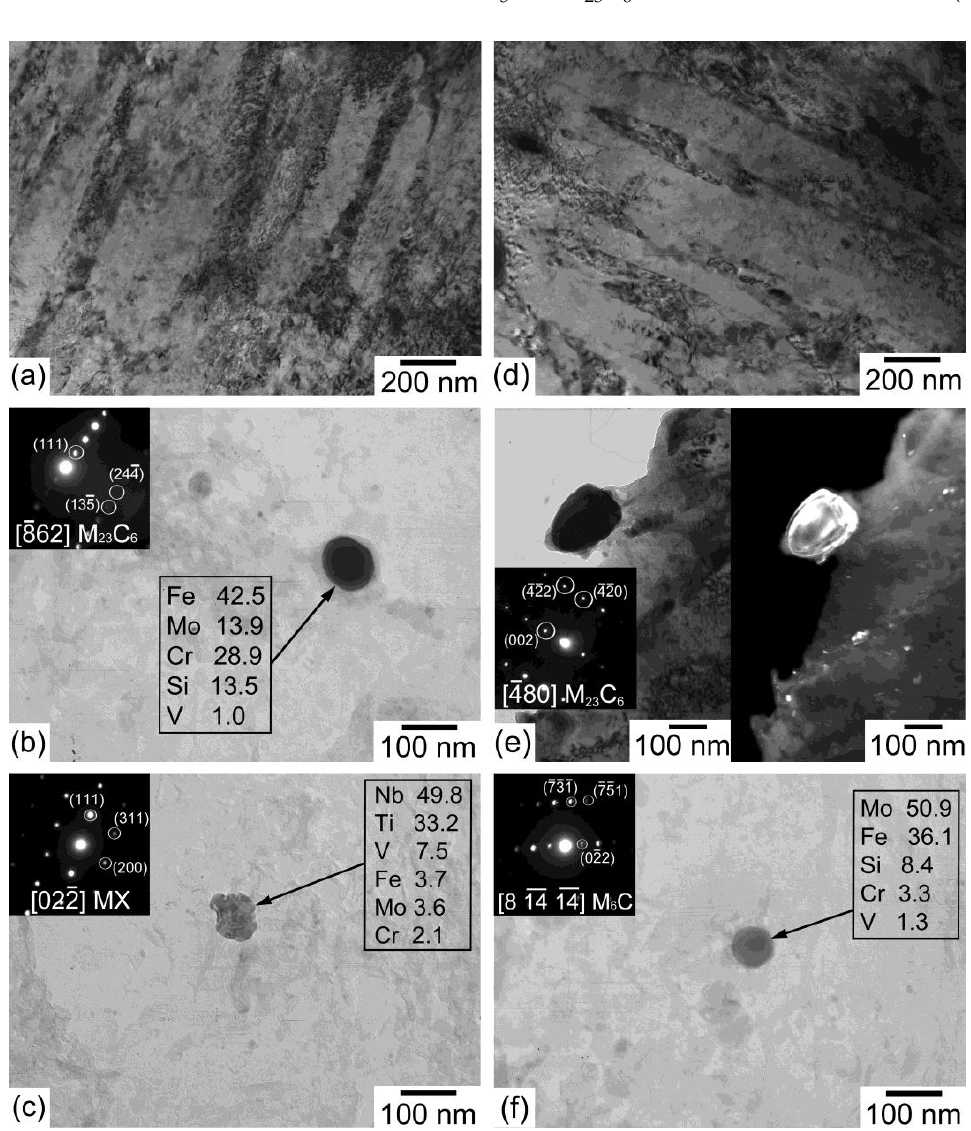
Figure 9. Typical microstructures of the steel after quenching and tempering at 500 °C ( a – c ) and 600 °C ( d – f ): TEM micrograph of martensite lath structure with carbide particles at 500 °C ( a ) and 600 °C ( d ); TEM micrograph of M 23 C 6 carbide on carbon replica after tempering at 500 °C ( b ) and on thin foil after tempering at 600 °C in bright (left side) and dark (right side) field ( e ); MX precipitates on carbon replica after tempering at 500 °C ( c ) and M 6 C carbide on carbon replica after tempering at 600 °C ( f ).